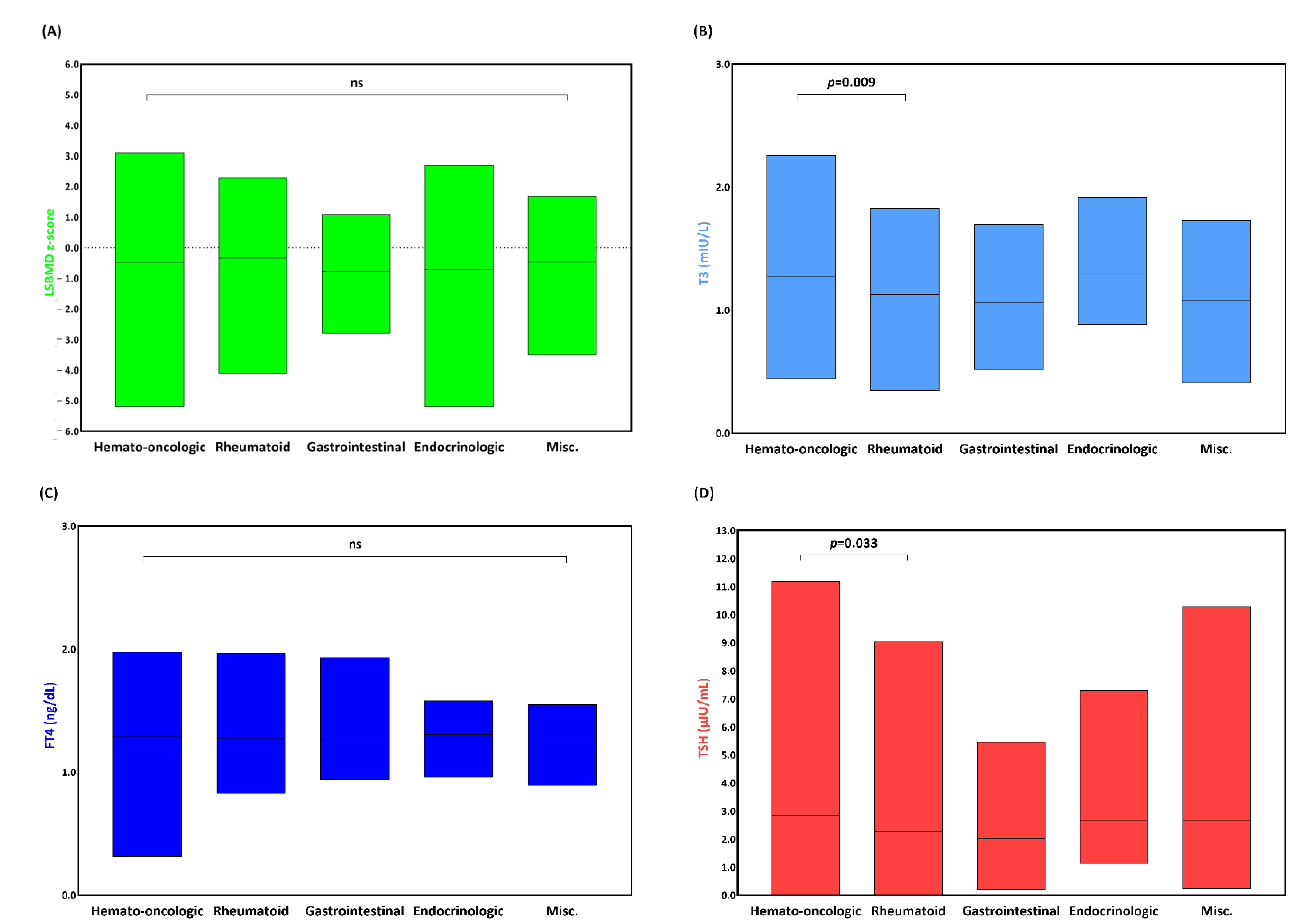
Figure 1. Floating bars comparing ( A ) lumbar spine bone mineral density (LSBMD), ( B ) triiodothyronine (T3), ( C ) free thyroxine (FT4), and ( D ) thyrotropin (TSH) based on underlying conditions. Each end of the bars represents minimum to maximum values, while a line drawn indicates a mean value. The p -value is listed when it is significant, otherwise it is noted as non-specific (ns).